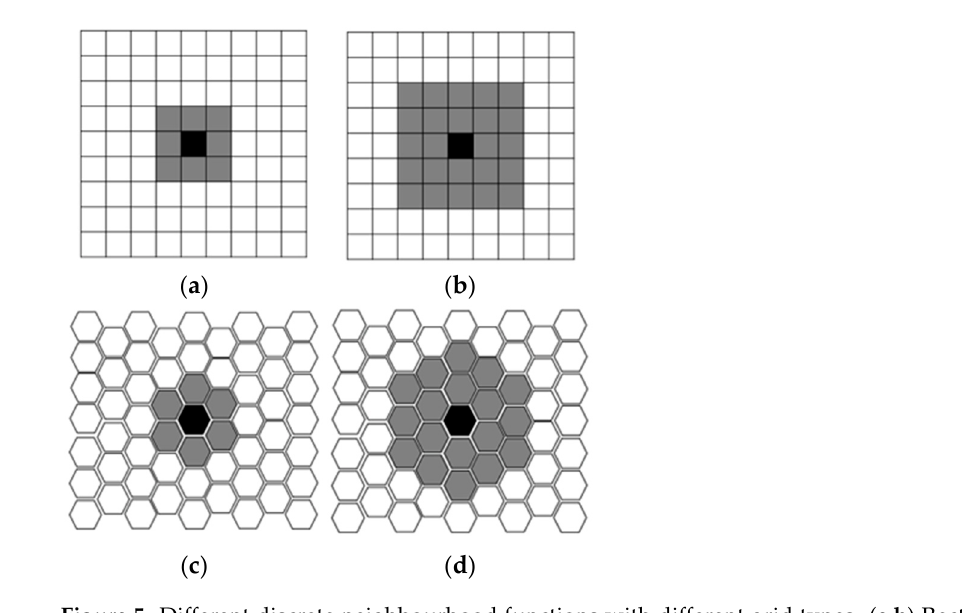
Figure 5. Different discrete neighbourhood functions with different grid types. ( a , b ) Rectangular SOM Grid; ( c , d ) Hexagonal SOM Grid.